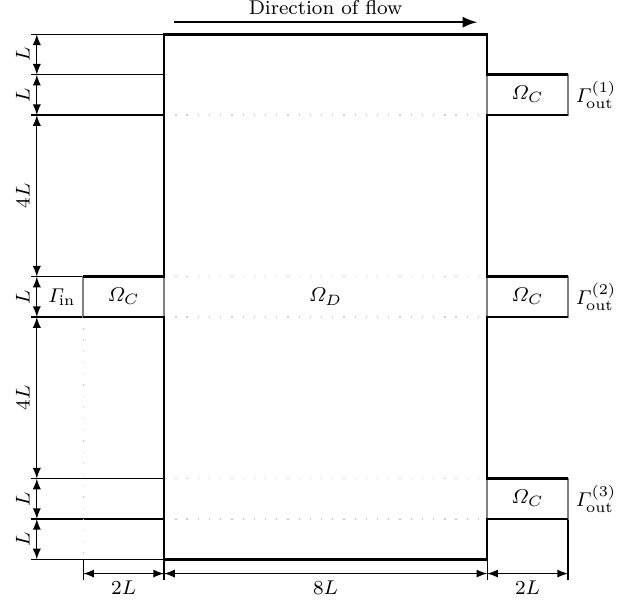
Figure 10. Computational domain for the second test problem. Here, the computational domain Ω comprises the design domain Ω D as well as four channels Ω C that are connected to the inlet and outlets of the